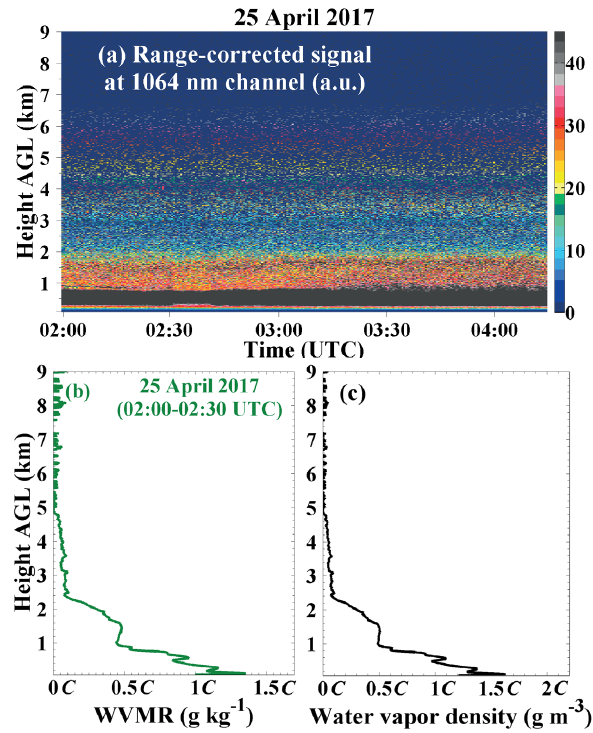
Figure 6. (a) Temporal development of the range-corrected signal at 1064nm, (b) 30min mean water vapor mixing ratio profile mea- sured on 25 April 2017 from 02:00 to 02:30UTC, and (c) the corre- sponding water vapor density profile. Note that the calibration con- stant C is not yet determined.